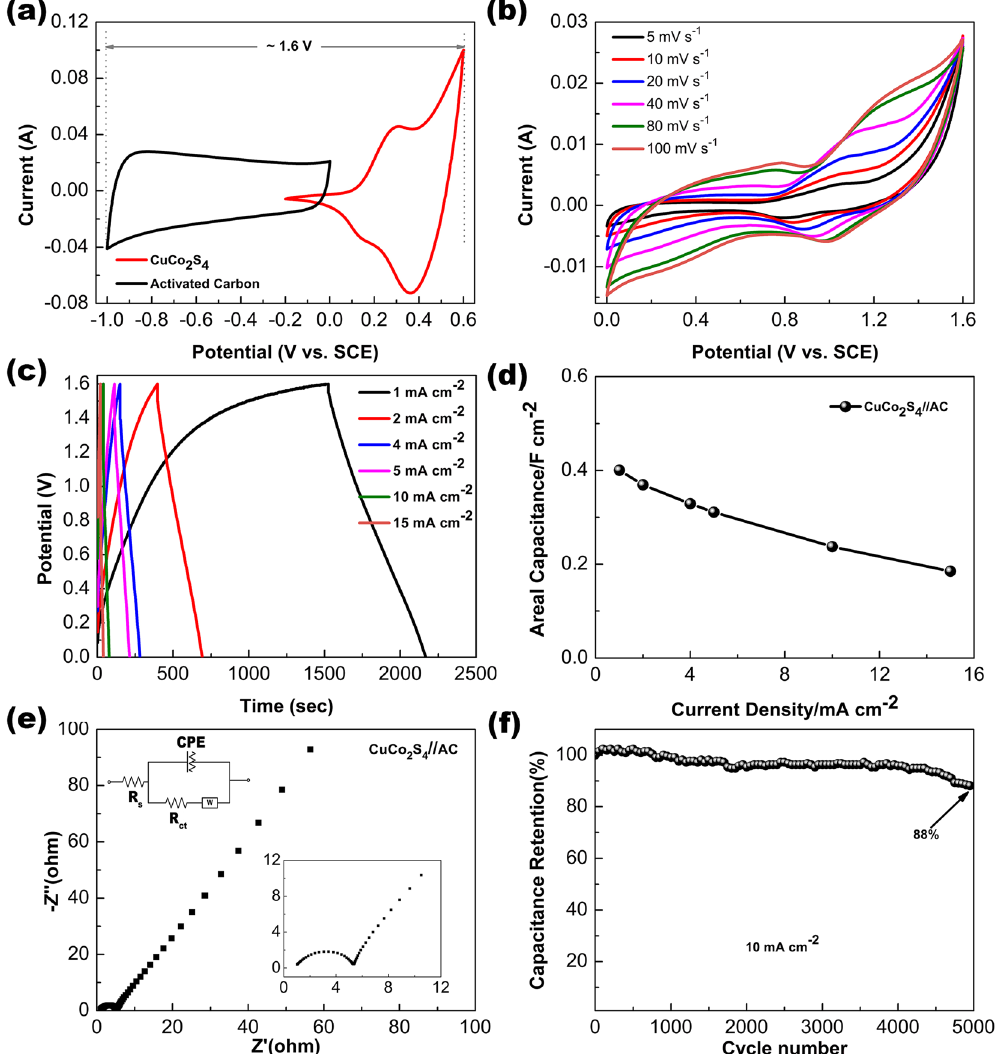
Figure 6. ( a ) CV curves of AC and CuCo 2 S 4 NRAs electrodes at the scan rate of 10 mV s − 1 , ( b ) CV curves of the CuCo 2 S 4 //AC ASC at various scan rates, ( c ) GCD curves of the ASC at various current densities, ( d ) specific capacitance of the ASC as a function of current density, ( e ) Nyquist plot of the ASC recorded from 0.01 to 100 kHz at open circuit potential at open circuit potential, the insets show the equivalent circuit (top left) and enlarged Nyquist plot (bottom right) ( f ) cycling performance of the of the ASC at 10 mA cm − 2